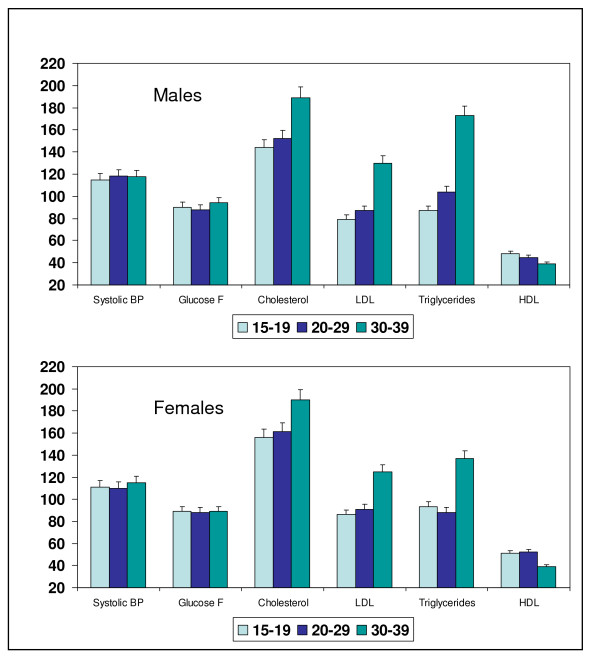
Age-related escalation in mean levels of systolic BP, fasting glucose, total cholesterol, LDL cholesterol and triglycerides and decline in HDL cholesterol levels in males and females (p for trend < 0.01). Values of systolic BP are in mm Hg and the others in mg/dl. Bars and whiskers indicate mean and SEM values respectively.